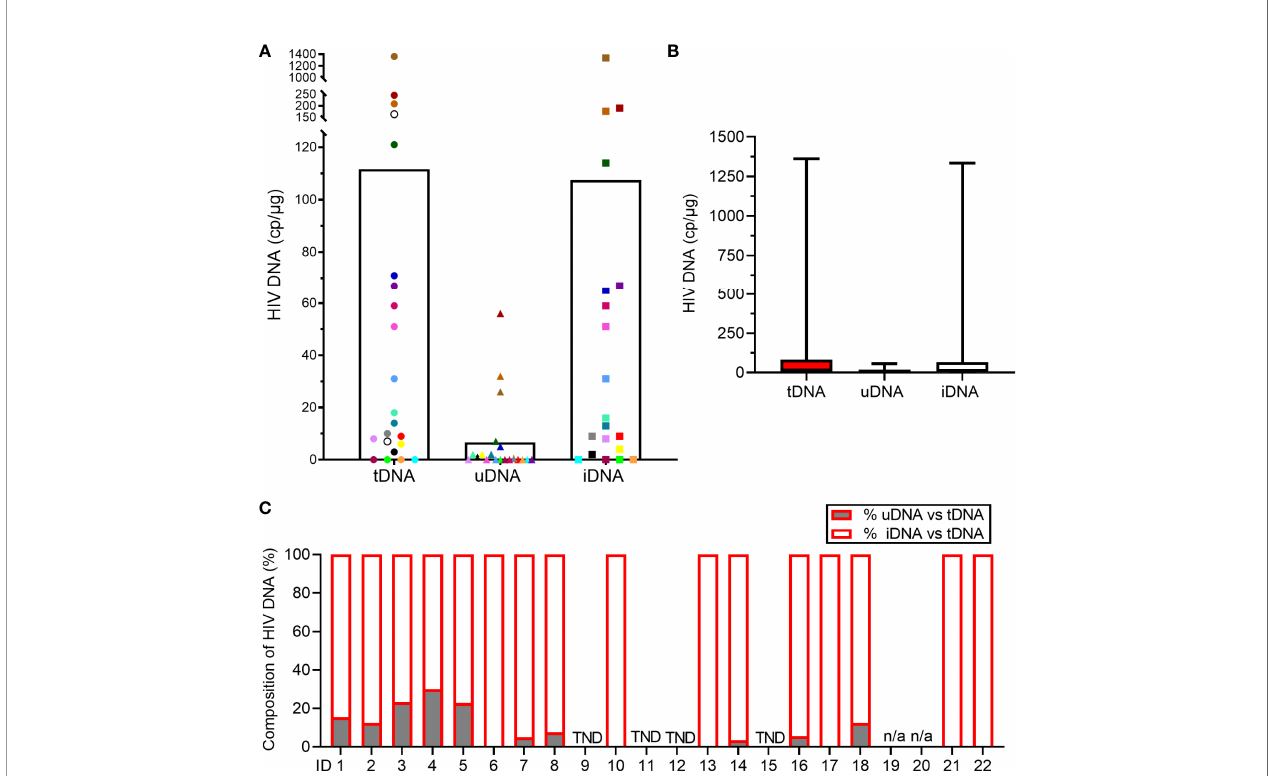
FIGURE 2 | Measurements of HIV DNA reservoir in the study population. (A) Levels of total (tDNA), unintegrated (uDNA) and integrated (iDNA) HIV DNA. Each dot represents one patient sample and the white histogram represents the mean. Two patients ’ samples did not yield suf fi cient cellular DNA for uDNA and iDNA analysis (open circles). (B) Levels of tDNA, uDNA and iDNA. Data represent the median [IQR]. (C) Percentages of uDNA and iDNA among tDNA in each study participant. When uDNA copy numbers were < QL of the assay, the % were reduced to 0% (ID 6, 10, 13, 17, 21, 22). When tDNA, uDNA and iDNA copy numbers were < QL, the sample is reported as TND (target not detected; ID 9, 11, 12, 15). Samples, ID 19 and ID 20, were not analyzed for uDNA and iDNA (n/a, not